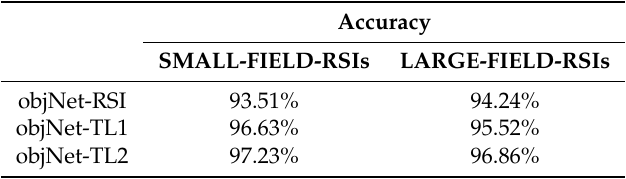
Table 6. The accuracy of objNet based on different transfer learning